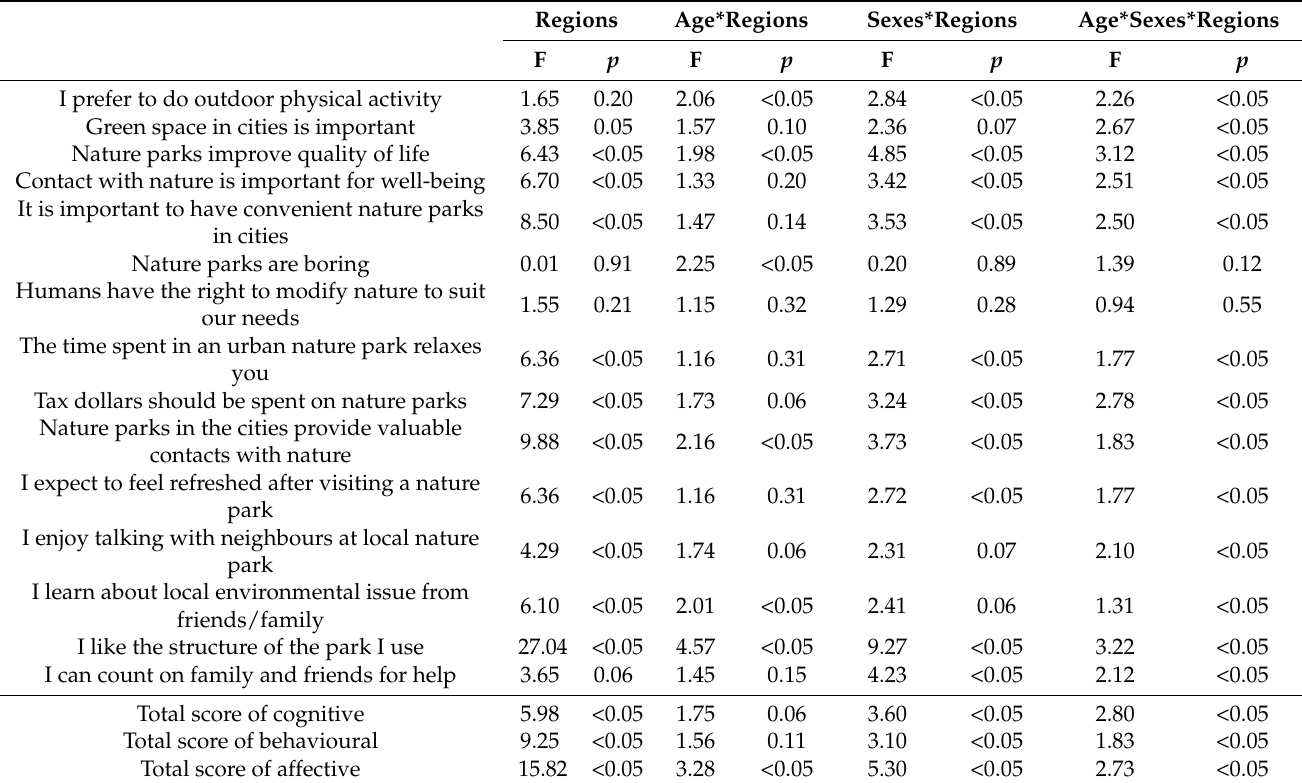
Table 5. Results of interaction of regions, sexes and age groups of non-parametric ANOVA.